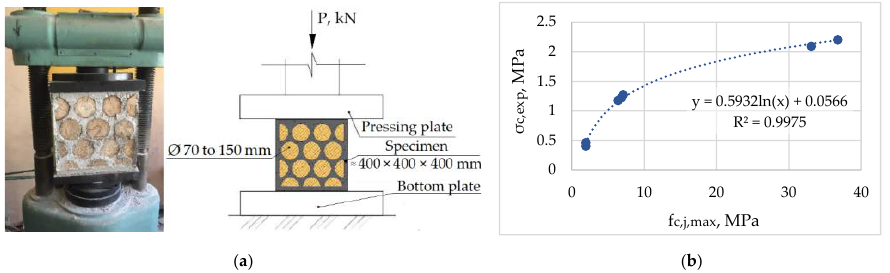
Figure 10. Result of cordwood specimens testing: ( a ) placement of the cordwood specimen in the testing machine; ( b ) mean compressive strength of cordwood as a function of the maximum compressive strength of the used